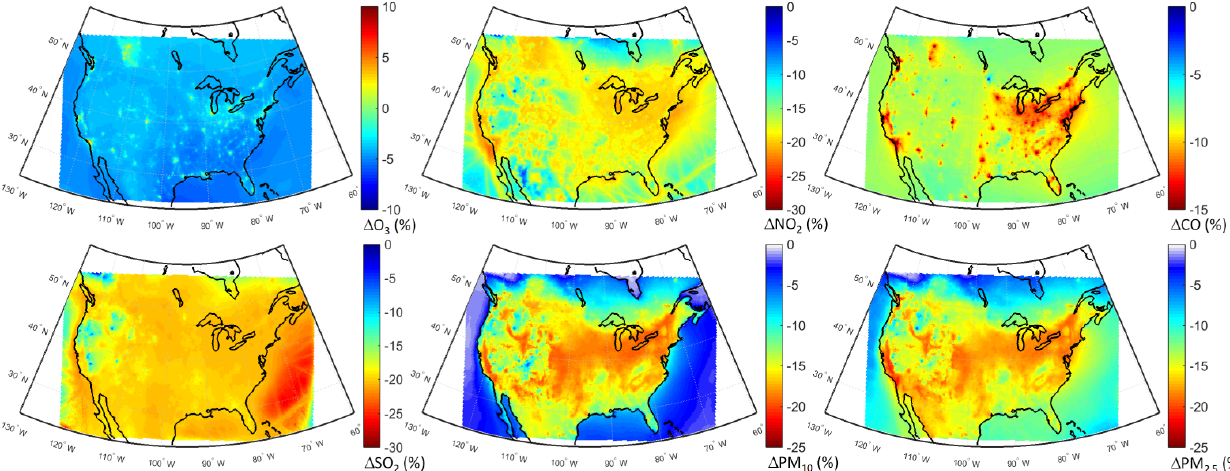
Figure 8. Spatial distribution of the annual mean relative differences between the global perturbation scenario and the base case over North America as simulated by the multi-model mean ensemble.